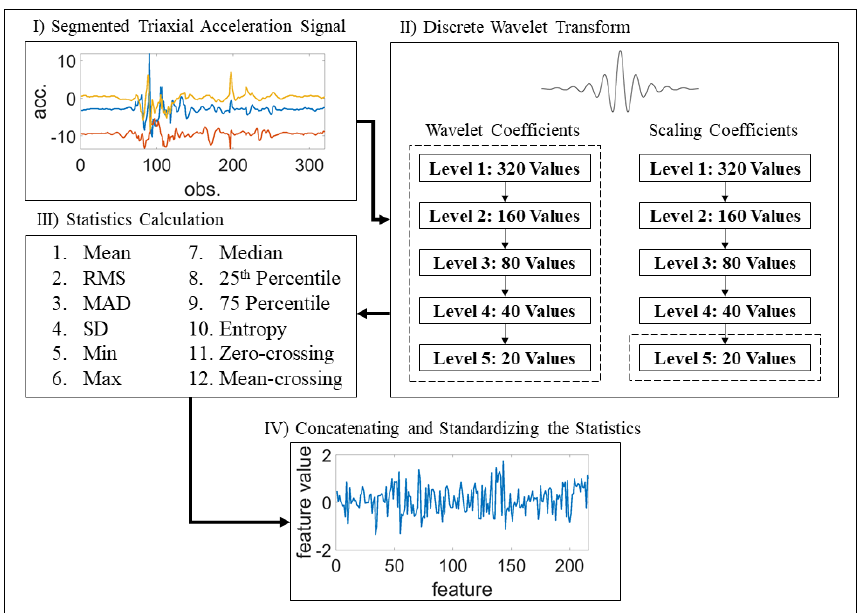
Figure 3. An overview of the feature extraction